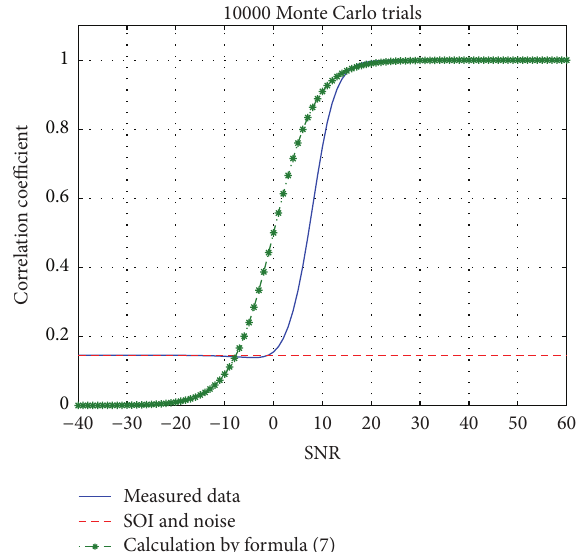
Figure 5: The relationship between correlation and